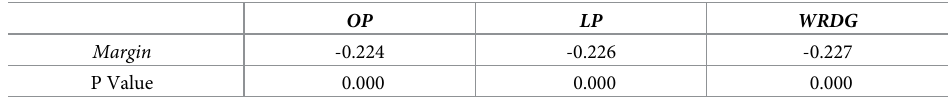
Table 11. Placebo test of model